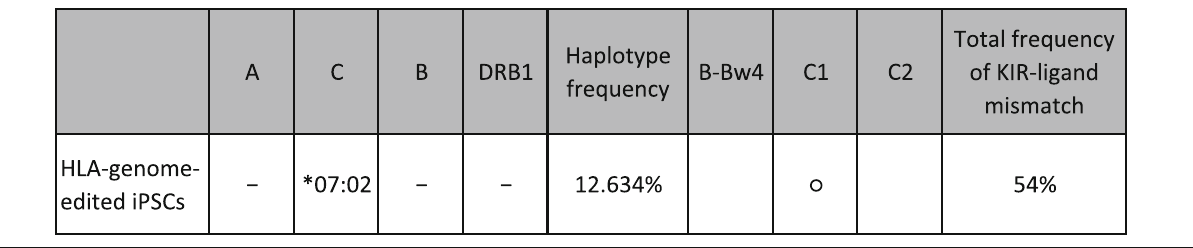
Table 2 Genome-edited HLA-homo-iPSCs and the frequencies of occurrence of KIR-ligand mismatch